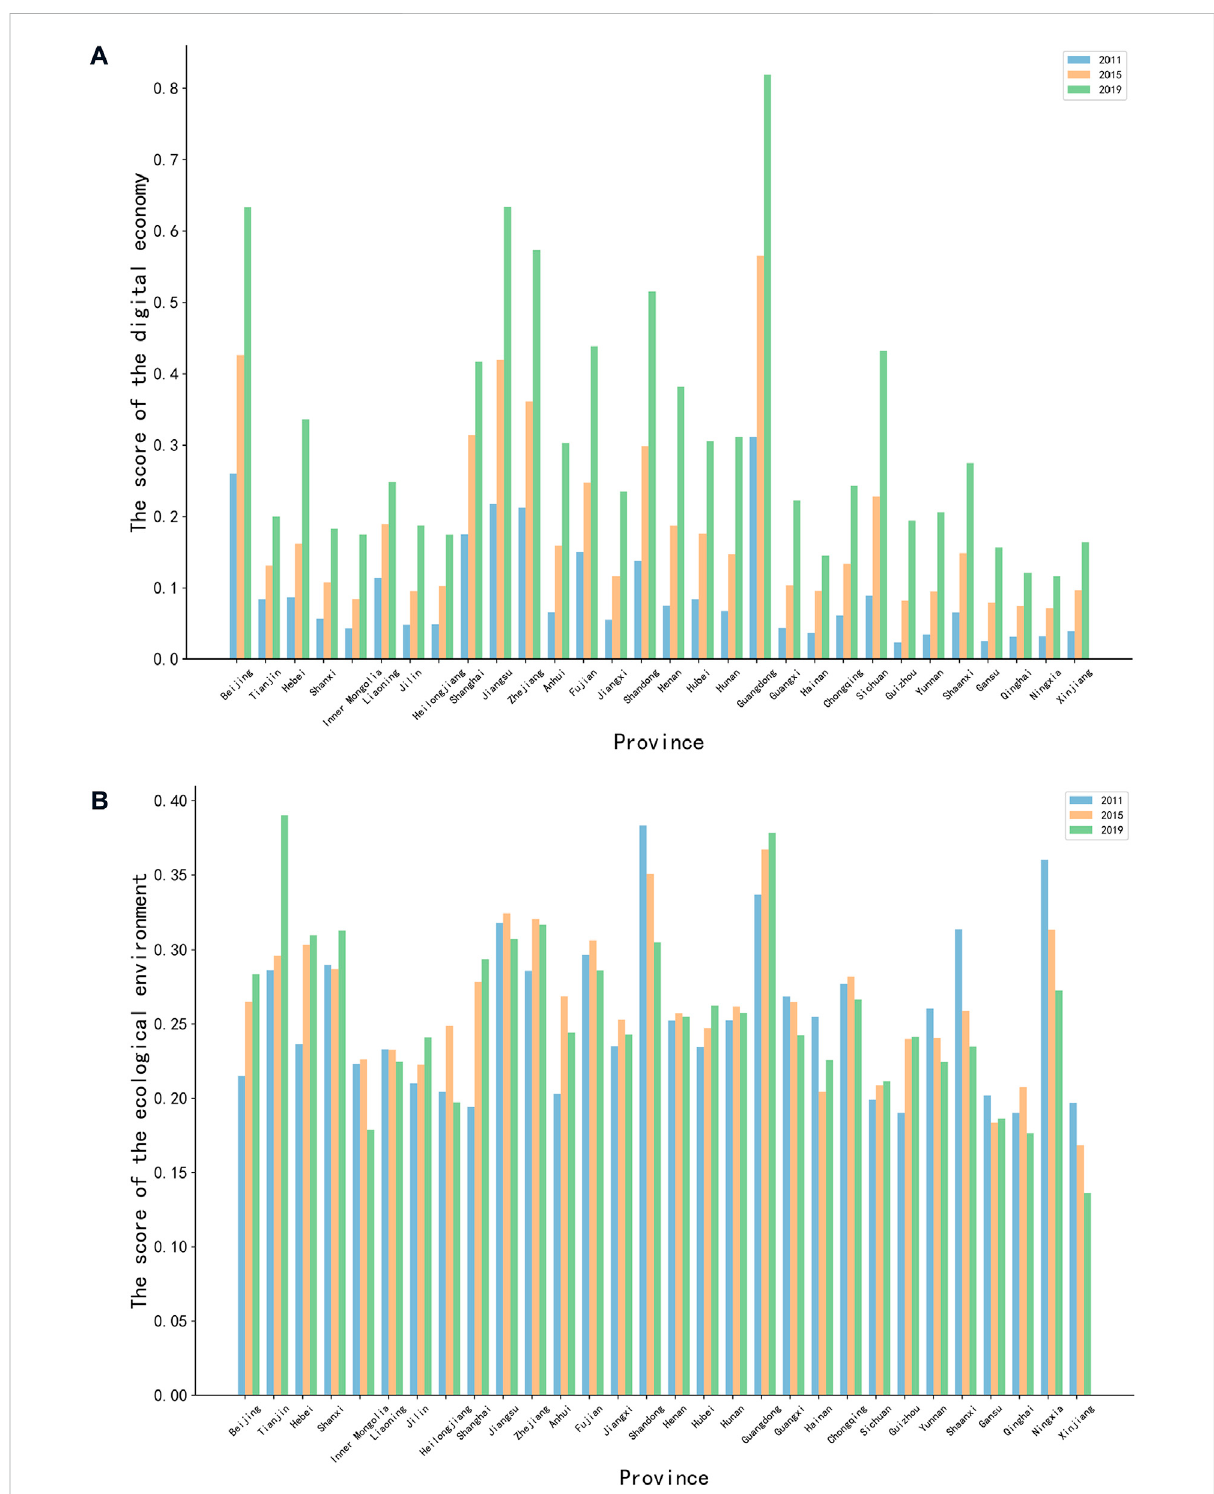
FIGURE 1 The score of the digital economy and ecological environment. (A) The score of the digital economy; (B) The score of ecological